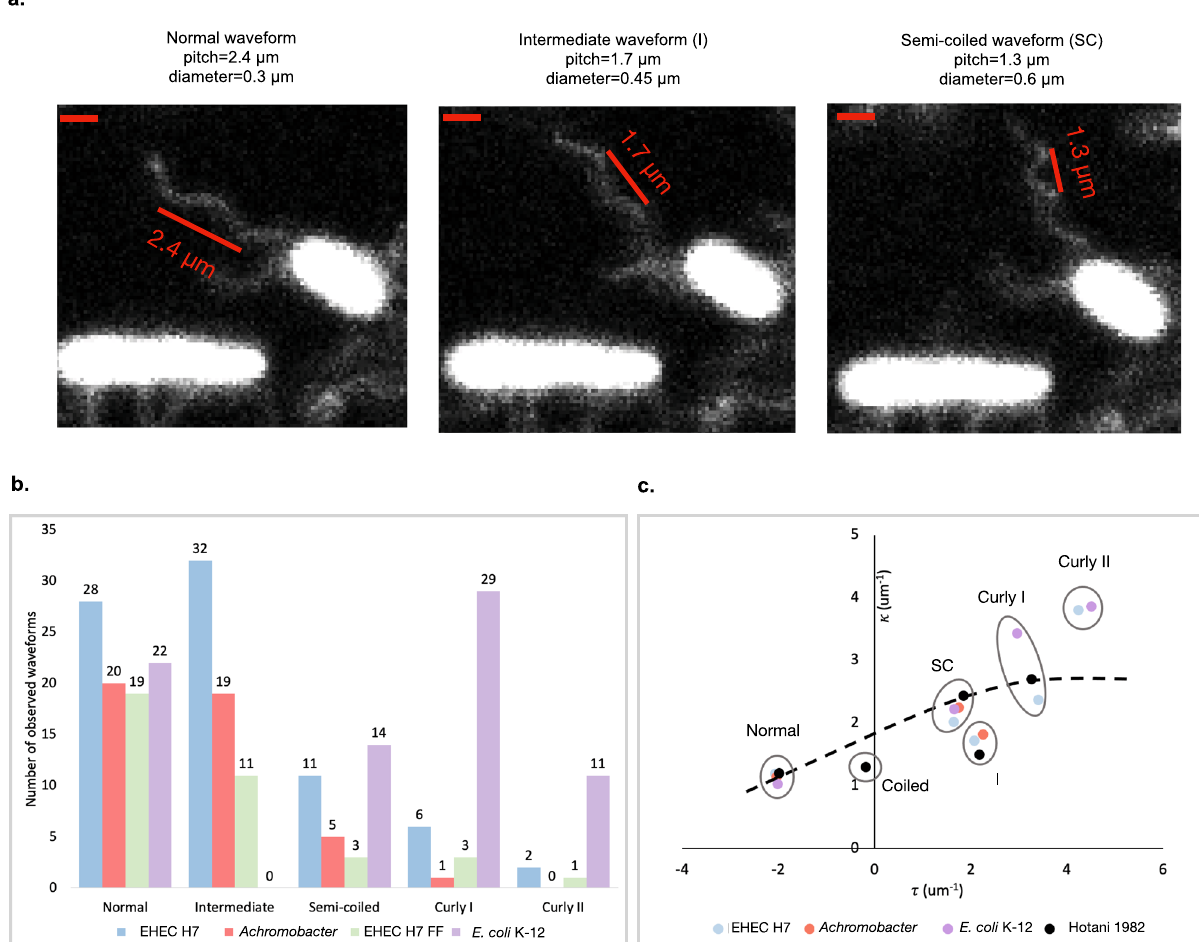
Fig. 7 ODS fl agellar fi laments commonly adopt an “ intermediate ” waveform. a Images of fl uorescently labeled Achromobacter sp. MFA1 R4 fl agellar fi laments with the three most common waveforms. Scale bars in the top left of each image correspond to ~1 µ m. b Bar graph of waveforms observed in rotating EHEC H7, Achromobacter sp. MFA1 R4, EHEC H7 FF mutant, and E. coli K-12 fl agellar fi laments. There were 55, 34, 25, and 54 unique fi laments whose polymorphic transitions were analyzed for the EHEC H7, Achromobacter sp. MFA1 R4, EHEC H7 FF mutant, and E. coli K-12 samples respectively. c Plot of curvature, κ , versus twist, τ , for the observed fl agellar waveforms. The black dots are measured waveforms from Hotani 49 . The black dashed line is the predicted curvature κ 12 as a function of τ . “ I ” stands for intermediate waveform and also includes the previously characterized “ medium ” waveform. “ SC ” stands for